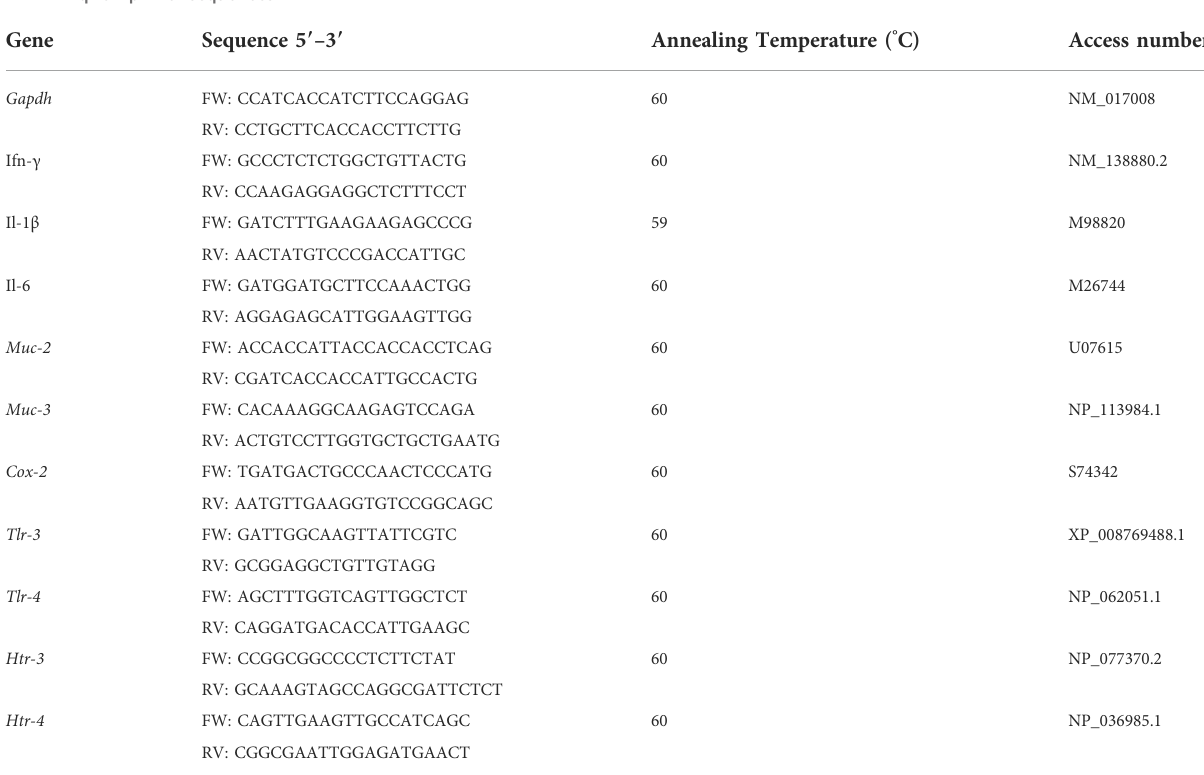
TABLE 1 qPCR primer